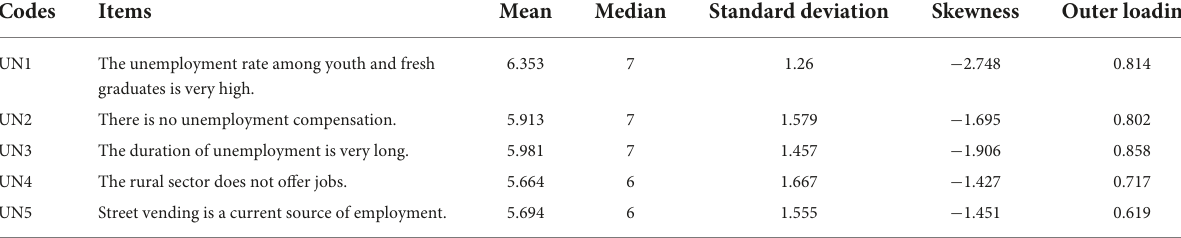
TABLE 5 Measurement properties of